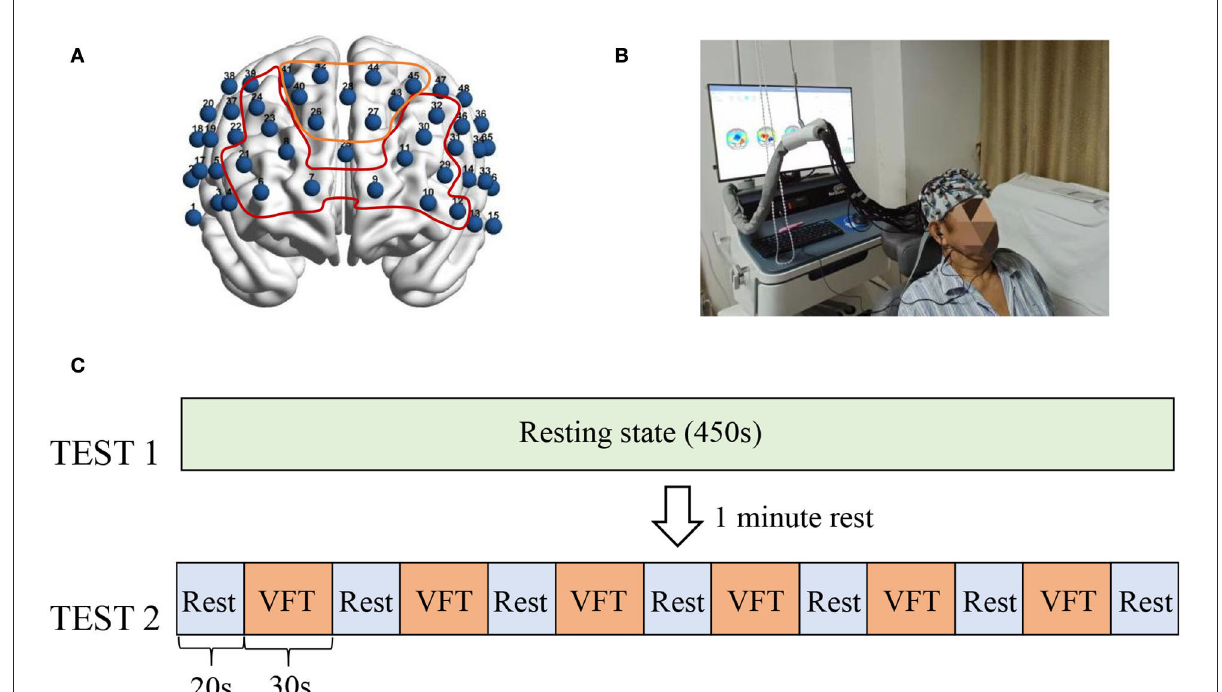
FIGURE1 fNIRS channel location and experimental paradigm. (A) Shows the brain regions corresponding to the 48 channels, with the numbers indicating the channel numbers. The yellow curve corresponds to the frontopolar area and its channels (CH41, CH40, C42, CH26, CH28, CH44, CH27, CH43, and CH45). The red area indicates the dorsolateral prefrontal cortex and its covered channels (CH6, CH7, CH21, CH8, CH23, CH24, CH9, CH10, CH11, CH29, CH30, CH32, and CH12). (B) Shows a subject being tested by fNIRS. (C) Shows the test paradigm. The fNIRS assessment was divided into two parts. The 450’s resting state (TEST1) was performed first, and the VFT task state was performed after a 1-min rest. The task state included a total of six blocks, each consisting of 30’s to execute the VFT task and 20’s to